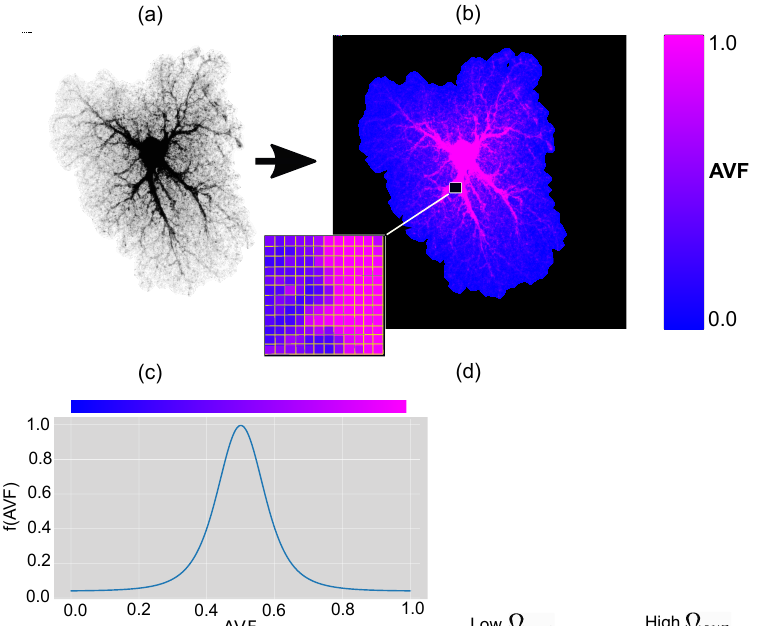
Figure 2. ( a , b ) AVF-based approach used to define intracellular mechanisms of Ca 2 + dynamics on the basis of the complex morphology of an astrocyte. ( a )—An experimental image of an astrocyte from the cell-centered database [44]; ( b )—the resulting 2D spatial AVF map. ( c , d ) Definition of synapse seeding. ( c )—Synapse density within astrocytic domain as a function of local AVF follows normal distribution as suggested by experimental data [45]; ( d )—example of the spatial pattern of synaptic terminals if drawn from the described distribution determined by local AVF values for small (0.05, left) and high (0.5, right) values of Ω syn